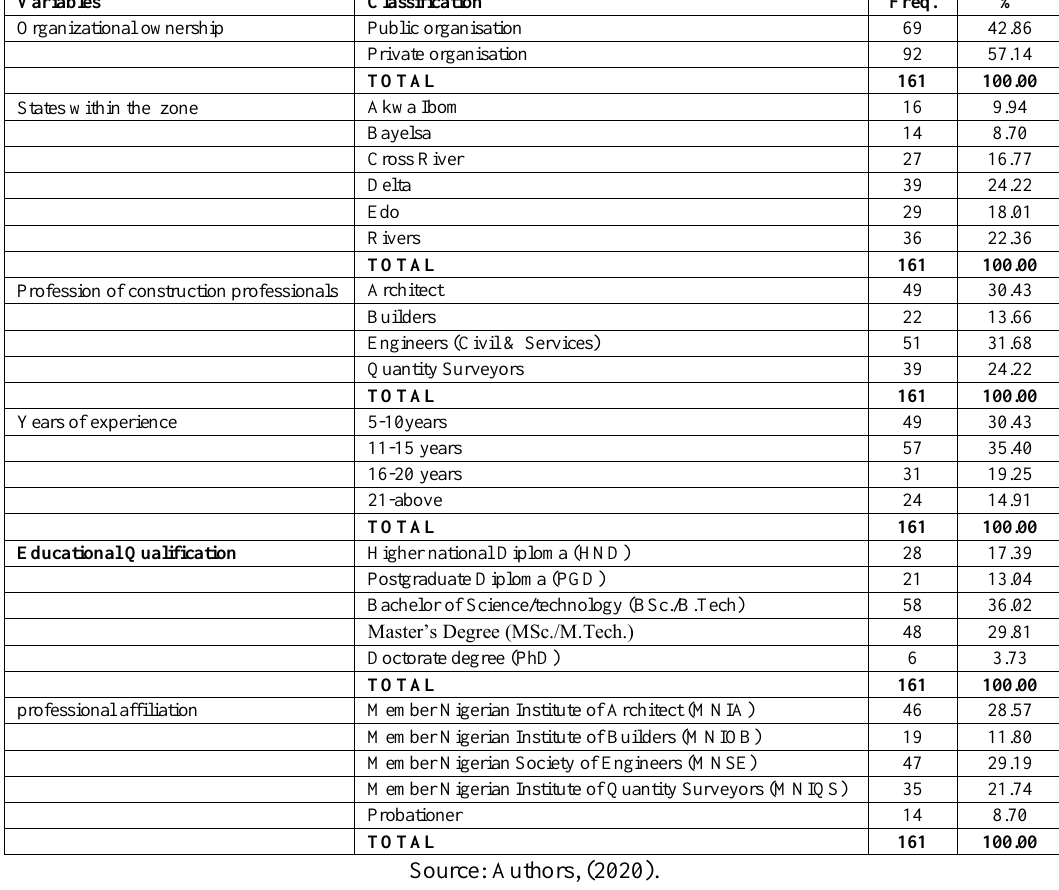
Table 1: Respondents Basic personal and Organisational information.